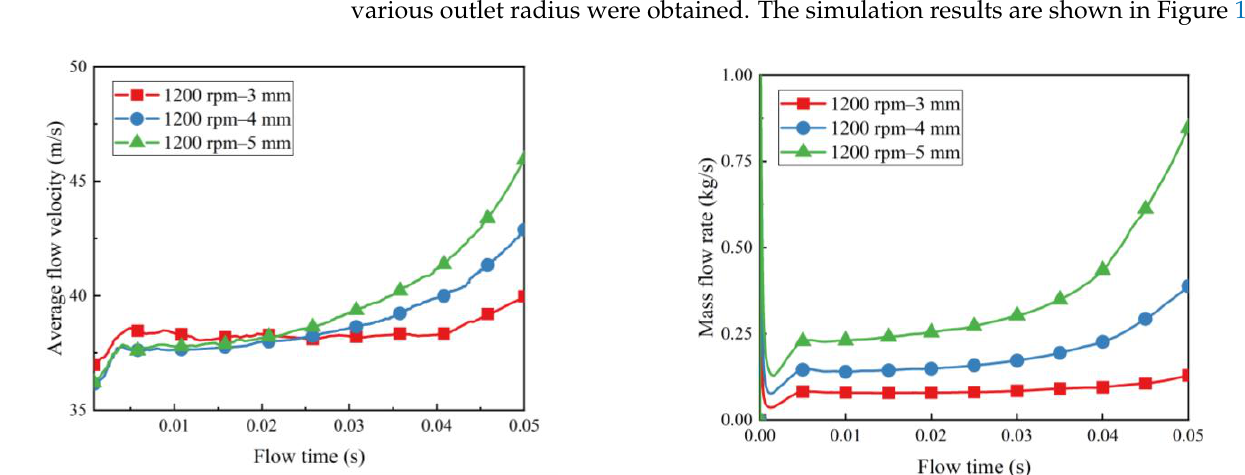
Figure 15. Variation of outlet average flow velocity at variable section ( left ) and mass average flow velocity ( right ).